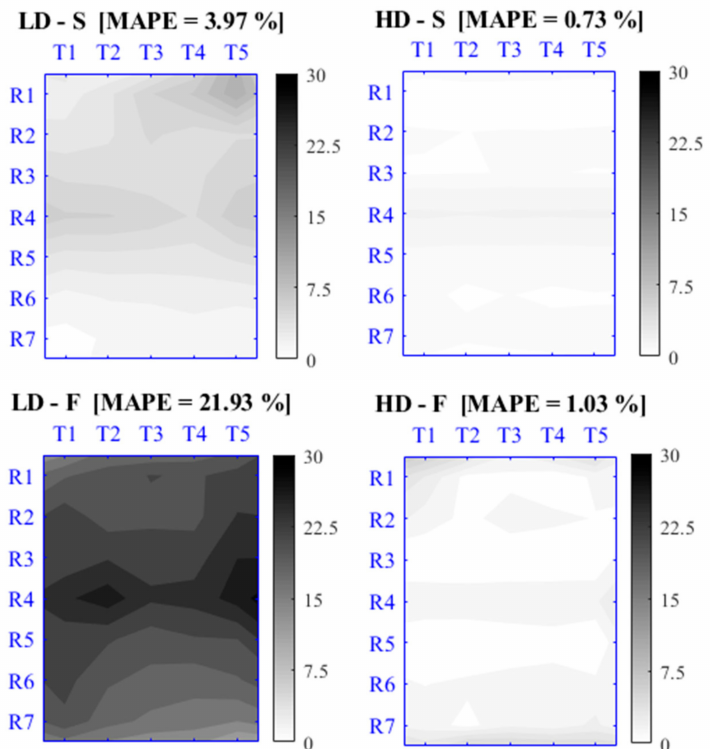
Figure 7. Maps of APE i for 4 representative cases (median case in terms of MAPE ) of the scenarios under the ID-CON scheme, with low (LD—left graphs) and high (HD—right graphs) seeding density and slow (S–top graphs) and fast (F-bottom